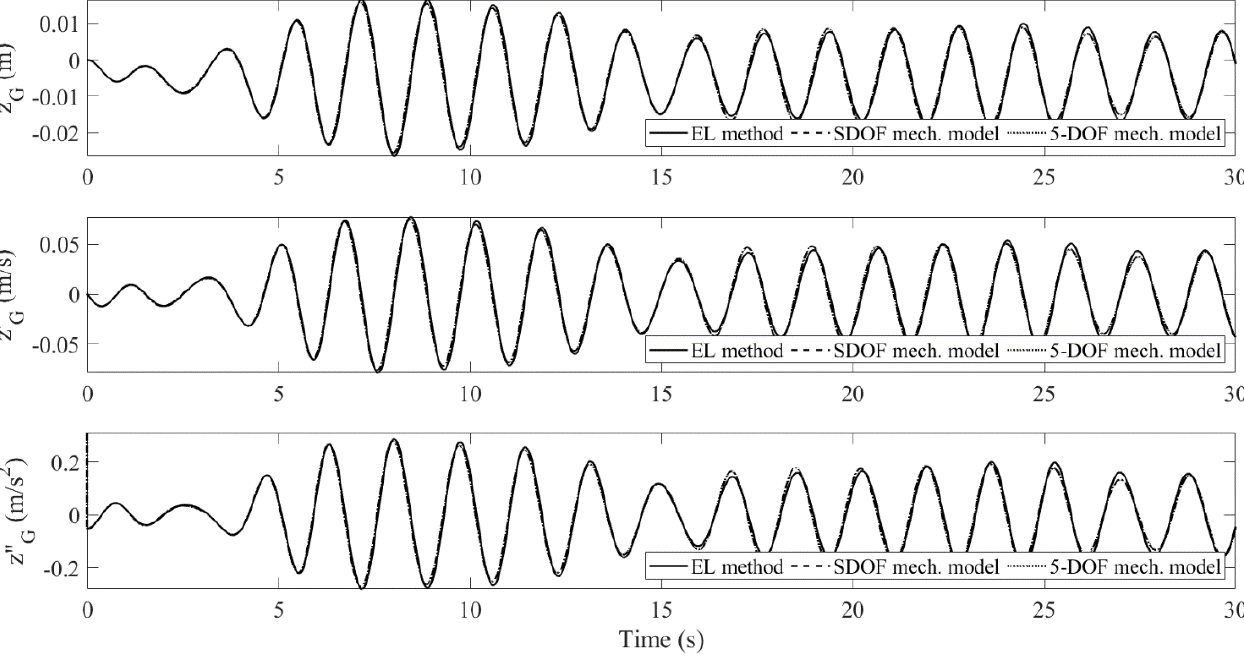
Figure 16. The heave motion responses of the floating body, configured with a water tank installed with porous media, undergoing small wave excitation.